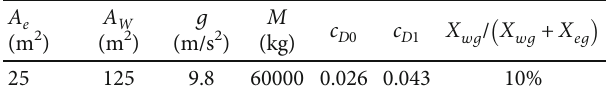
Table 4: Aircraft aerodynamic data.